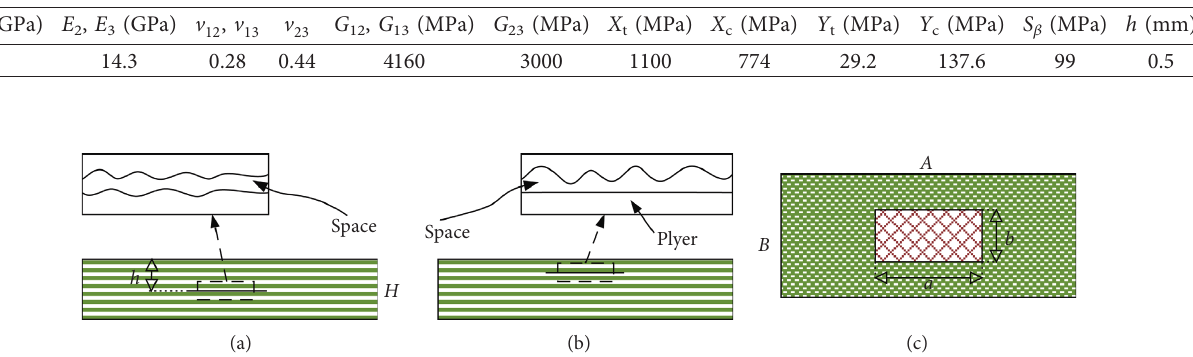
Table 1: Material properties of UDL.